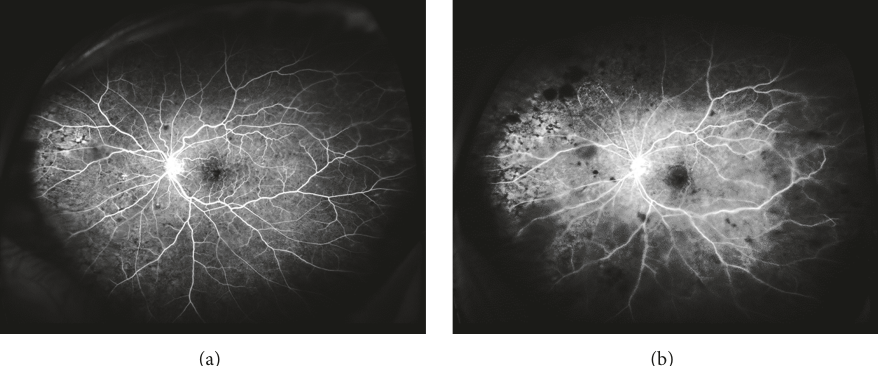
Figure 5: Fluorescein angiography image in the left eye at (a) initial visit demonstrating loss of small capillaries, but nonperfusion areas werenot observed. (b) 6 months after the initial visit demonstrating more than 10 discs areas of nonperfusion.